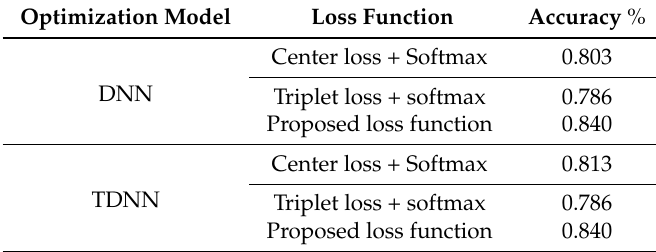
Table 5. Accuracy comparison with different optimization models and different loss functions.